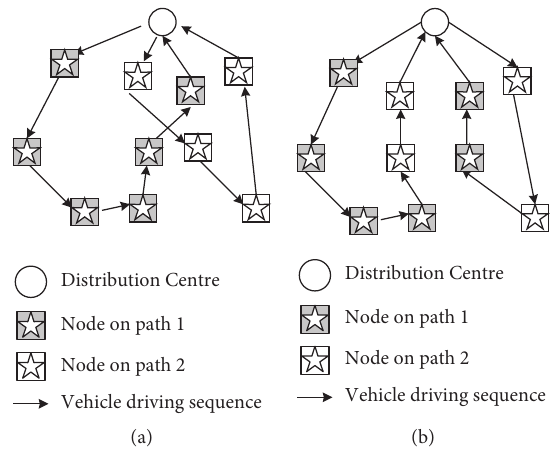
Figure 4: Cross2 neighborhood structure.